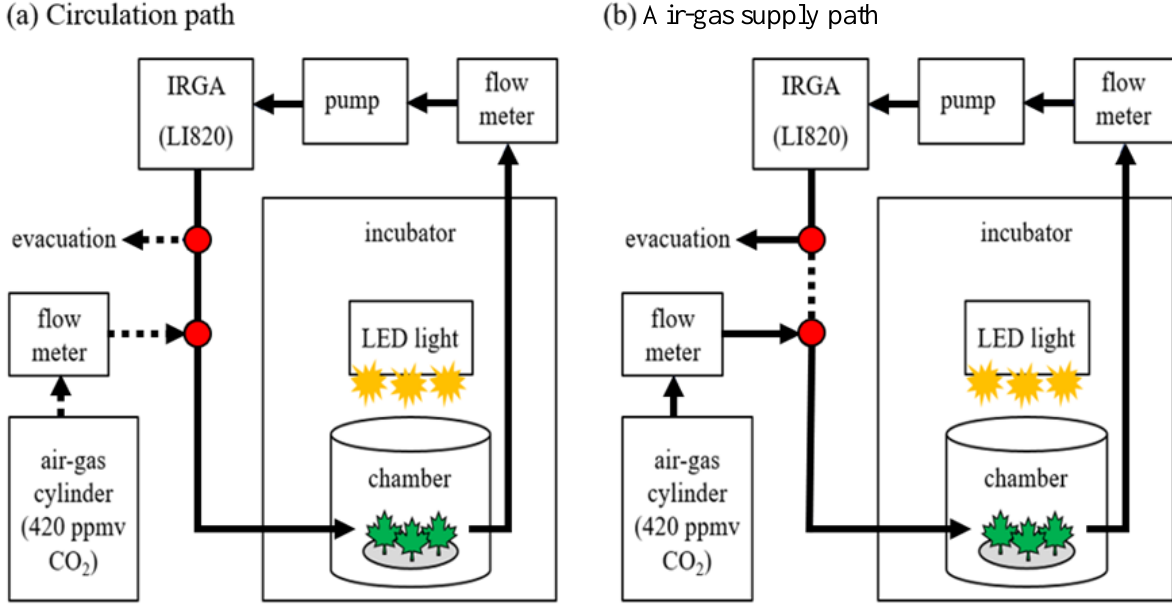
Figure 3. Photosynthesis measurement system. This system has two paths: (a) the circulation flow path to measure the CO absorption/emission rate; and (b) the (dry) air-gas supply path to reset the CO 2 concentration. Solid arrows in the schematic diagrams denote the air flow during the respective paths. Red circles are solenoid valves, and the broken arrows and line denote connections in which gas does not